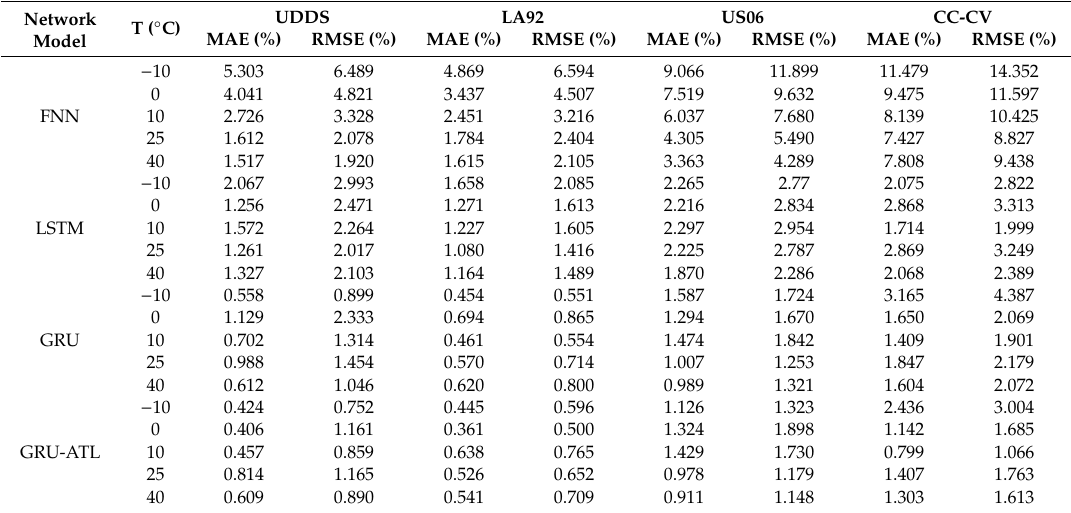
Table 3. SOC error results of four network models at five